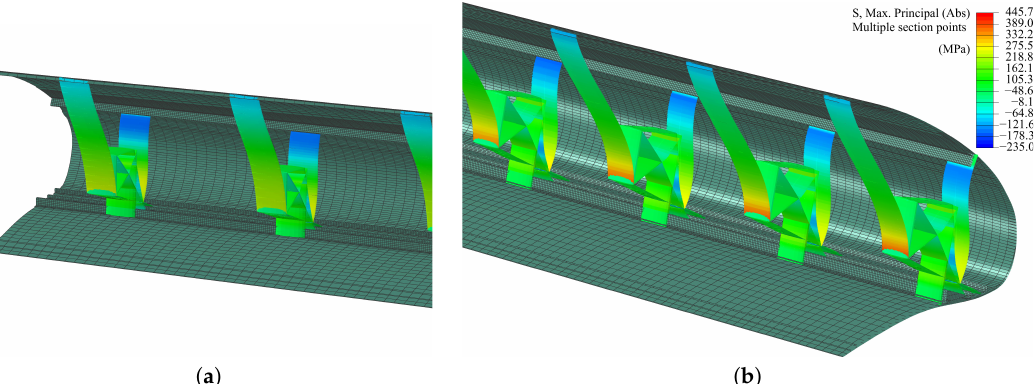
Figure 19. Stress distribution inside the compliant ribs at the wing tip ( a ) and wing root ( b